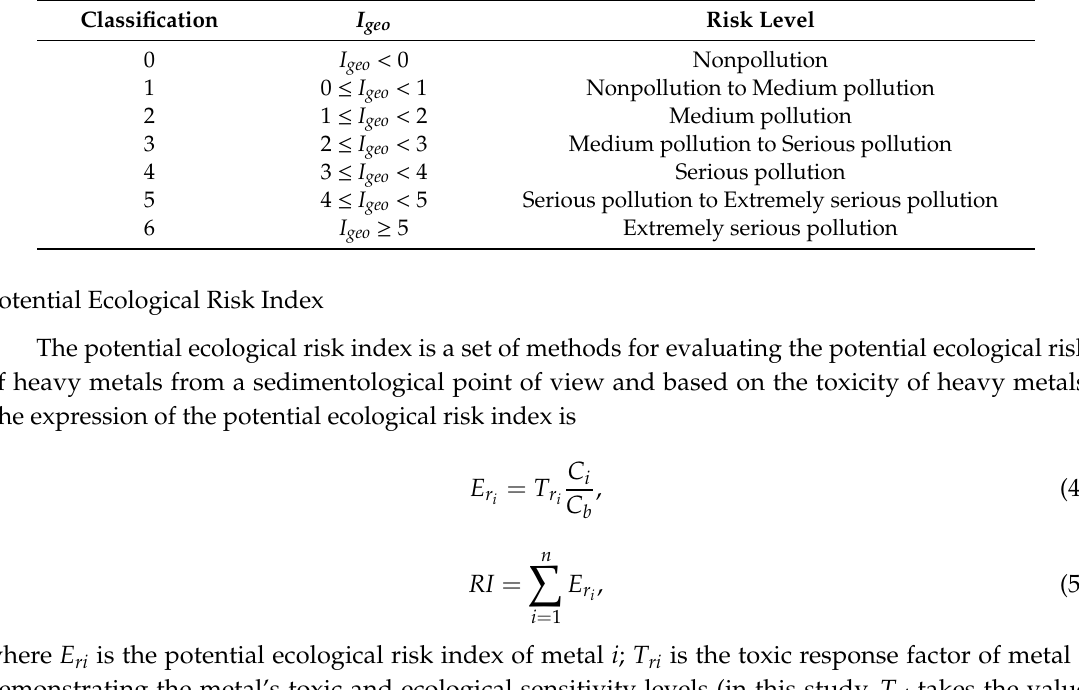
Table 3. Classification of the geo-accumulation